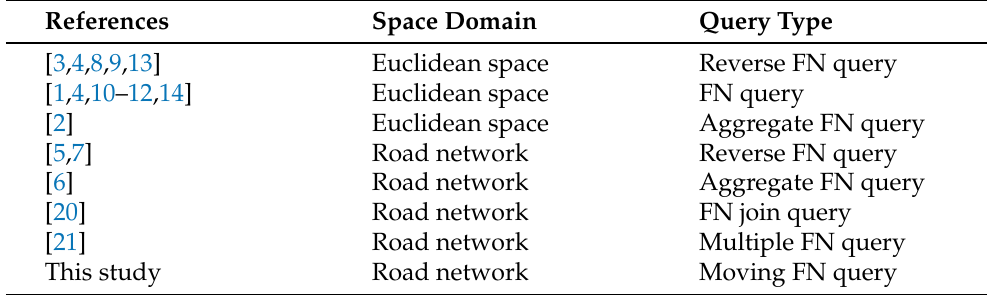
Table 1. Comparison between our problem scenario and those of previous